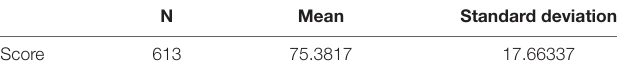
TABLE 4 | T -test: Differences among the participants based on gender.